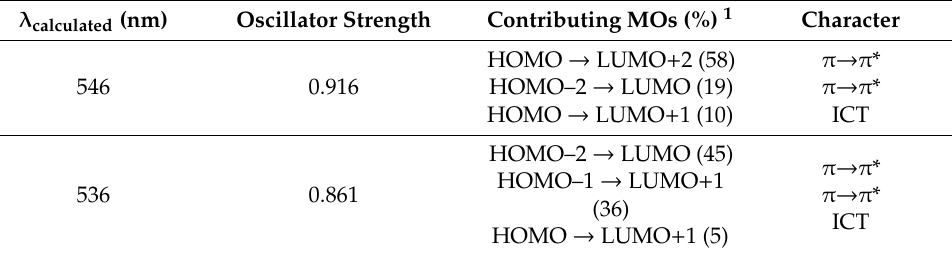
Table 2. Main electronic transitions for mer -Al( L3 ) 3 , calculated at the TD-CAM-B3LYP / 6-31G* // B3LYP / 6-31G* level of